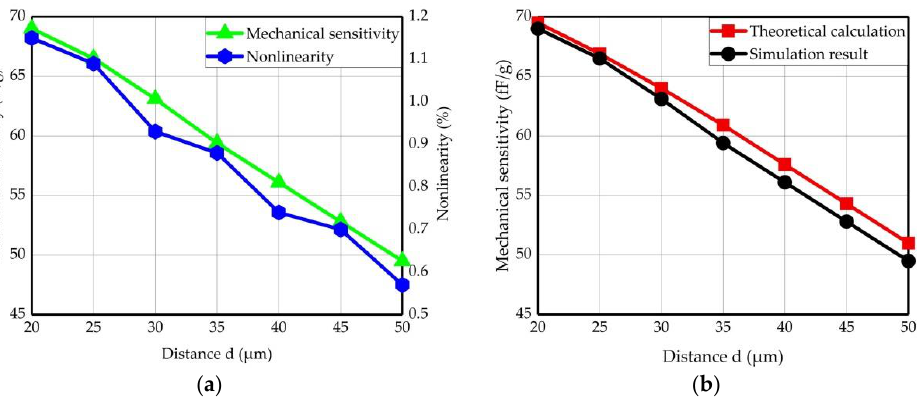
Figure 6. The simulation results of mechanical sensitivity and nonlinearity: ( a ) The simulation results of relationship between the nonlinearity and the mechanical sensitivity; ( b ) The theoretical calculation and simulation results of mechanical sensitivity.